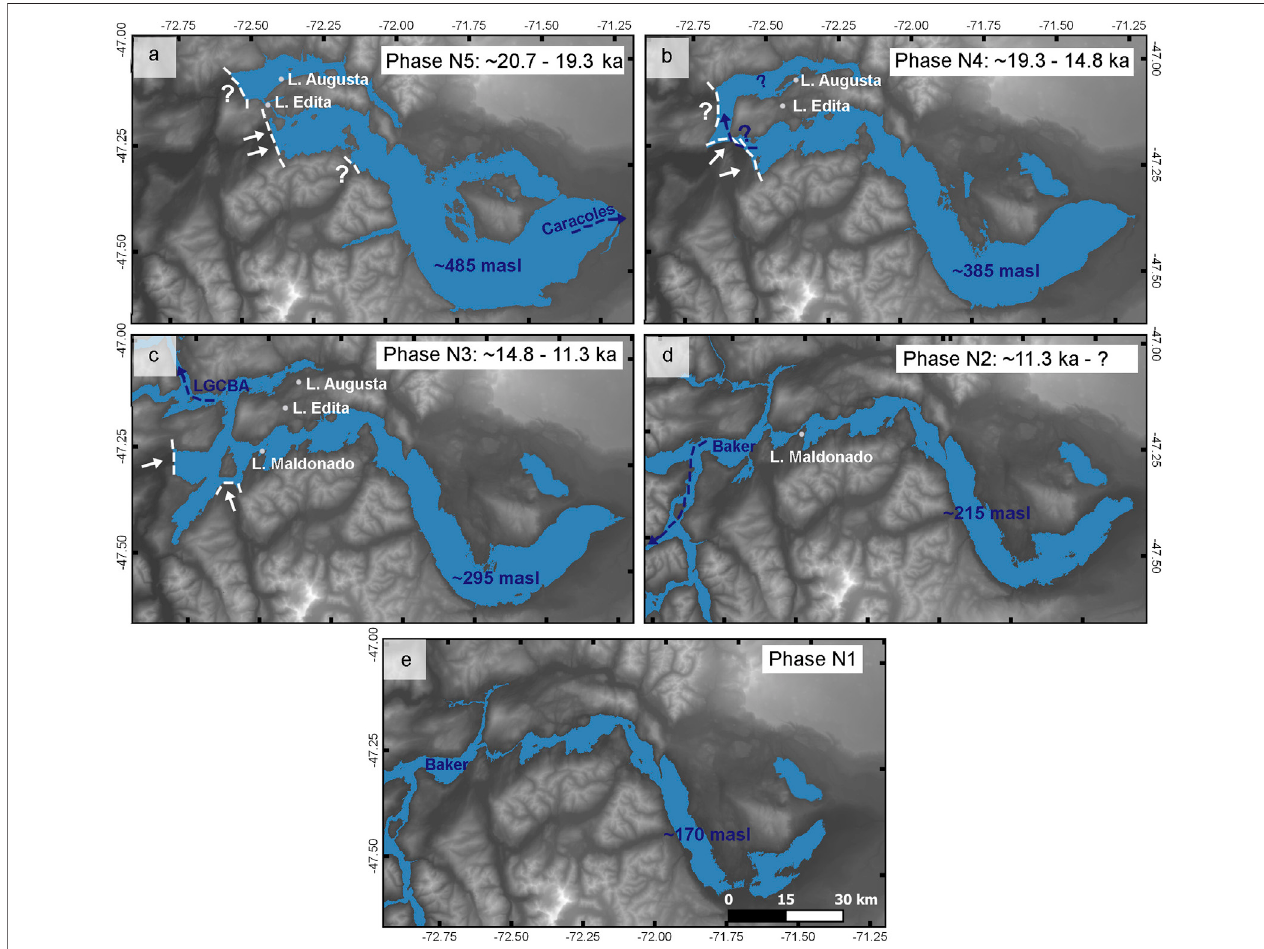
FIGURE 11 | Summary of the main phases proposed for the evolution of GLC. White dashed lines show inferred ice positions. Blue dashed lines show possible drainage routes. Paleolevels are shown inblue text. N5toN3 phases (A – C) showglacio-isostaticallycorrectedlandscapes. N2and N1reconstructions (D,E) arebased on current